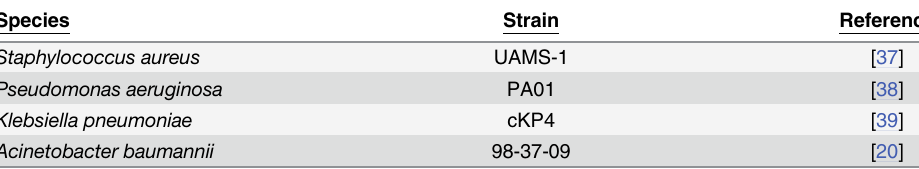
Table 1. Bacterial strains used in this